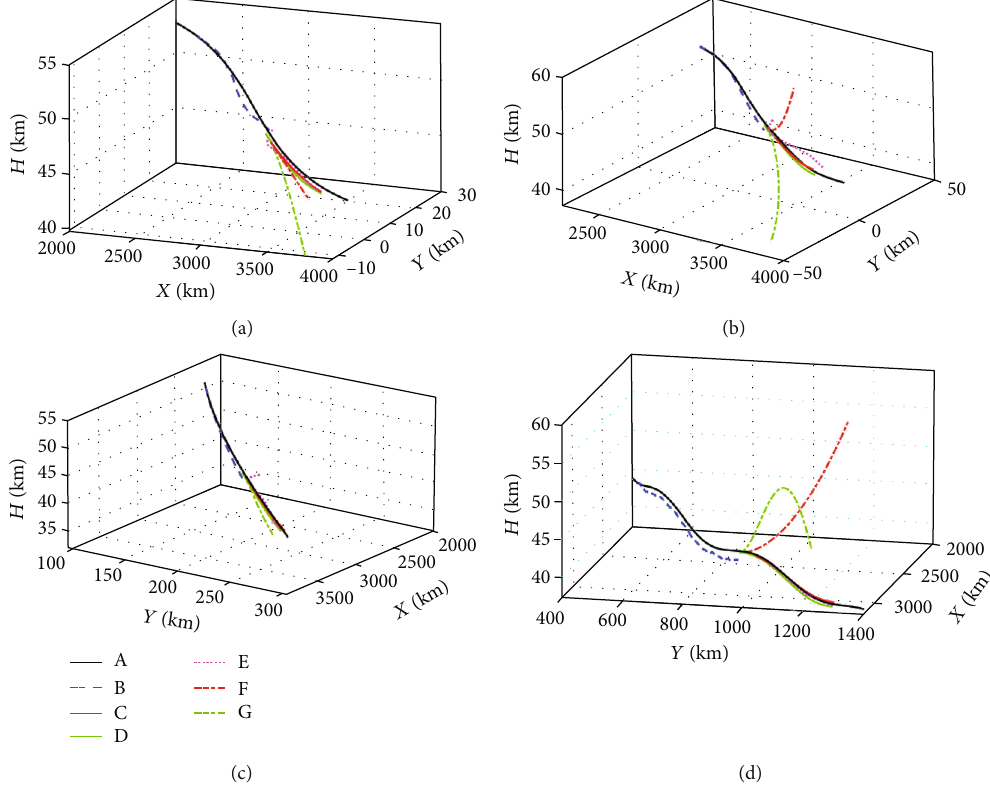
Figure 14: Comparison of prediction results for di ff erent methods. (a) is predicted trajectories in weaving equilibrium glide. (b) is predicted trajectories in weaving skip glide. (c) is predicted trajectories in turning equilibrium glide. (d) is predicted trajectories in turning equilibrium